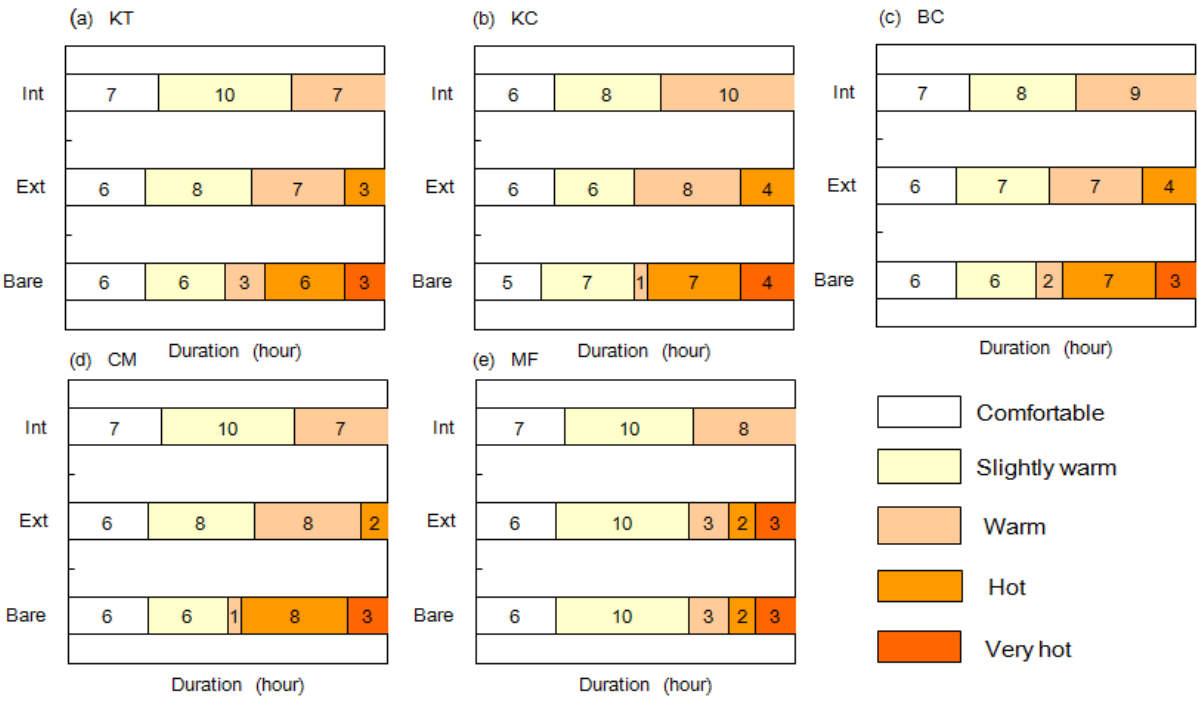
Figure 11. Thermal perception under the three roof scenarios at rooftop-podium level (Ext, Int and Bare denote respectively EGR, IGR and bare-roof